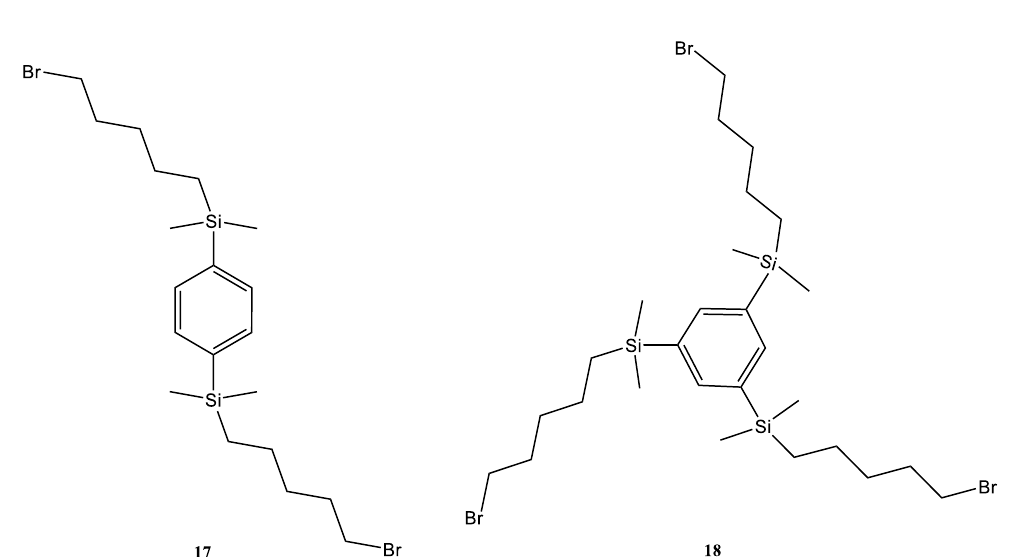
Figure 5. Structures of 1,4-bis((5-bromopentyl) dimethylsilyl) benzene and 1,3,5-tris((5-bromopentyl) dimethylsilyl) benzene.